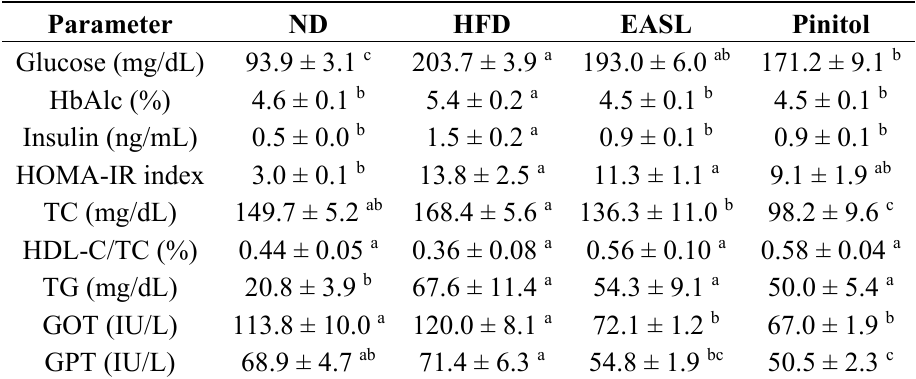
Table 2. Effects of EASL supplementation on plasma